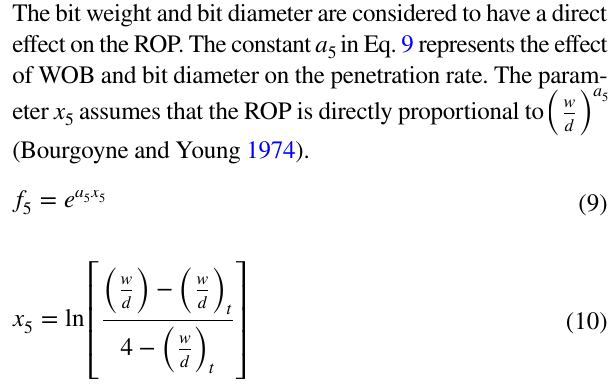
where f 4 is the rate of penetration (ft./h) and the a dimensionless coefficient for the effect of bottom hole pres- sure differential, ECD is equivalent circulating mud density at the bottom hole in units of ppg.